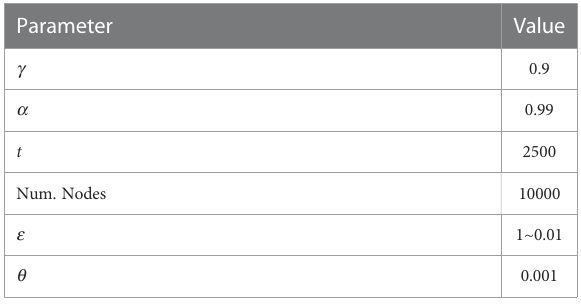
TABLE 2 The hyperparameters of